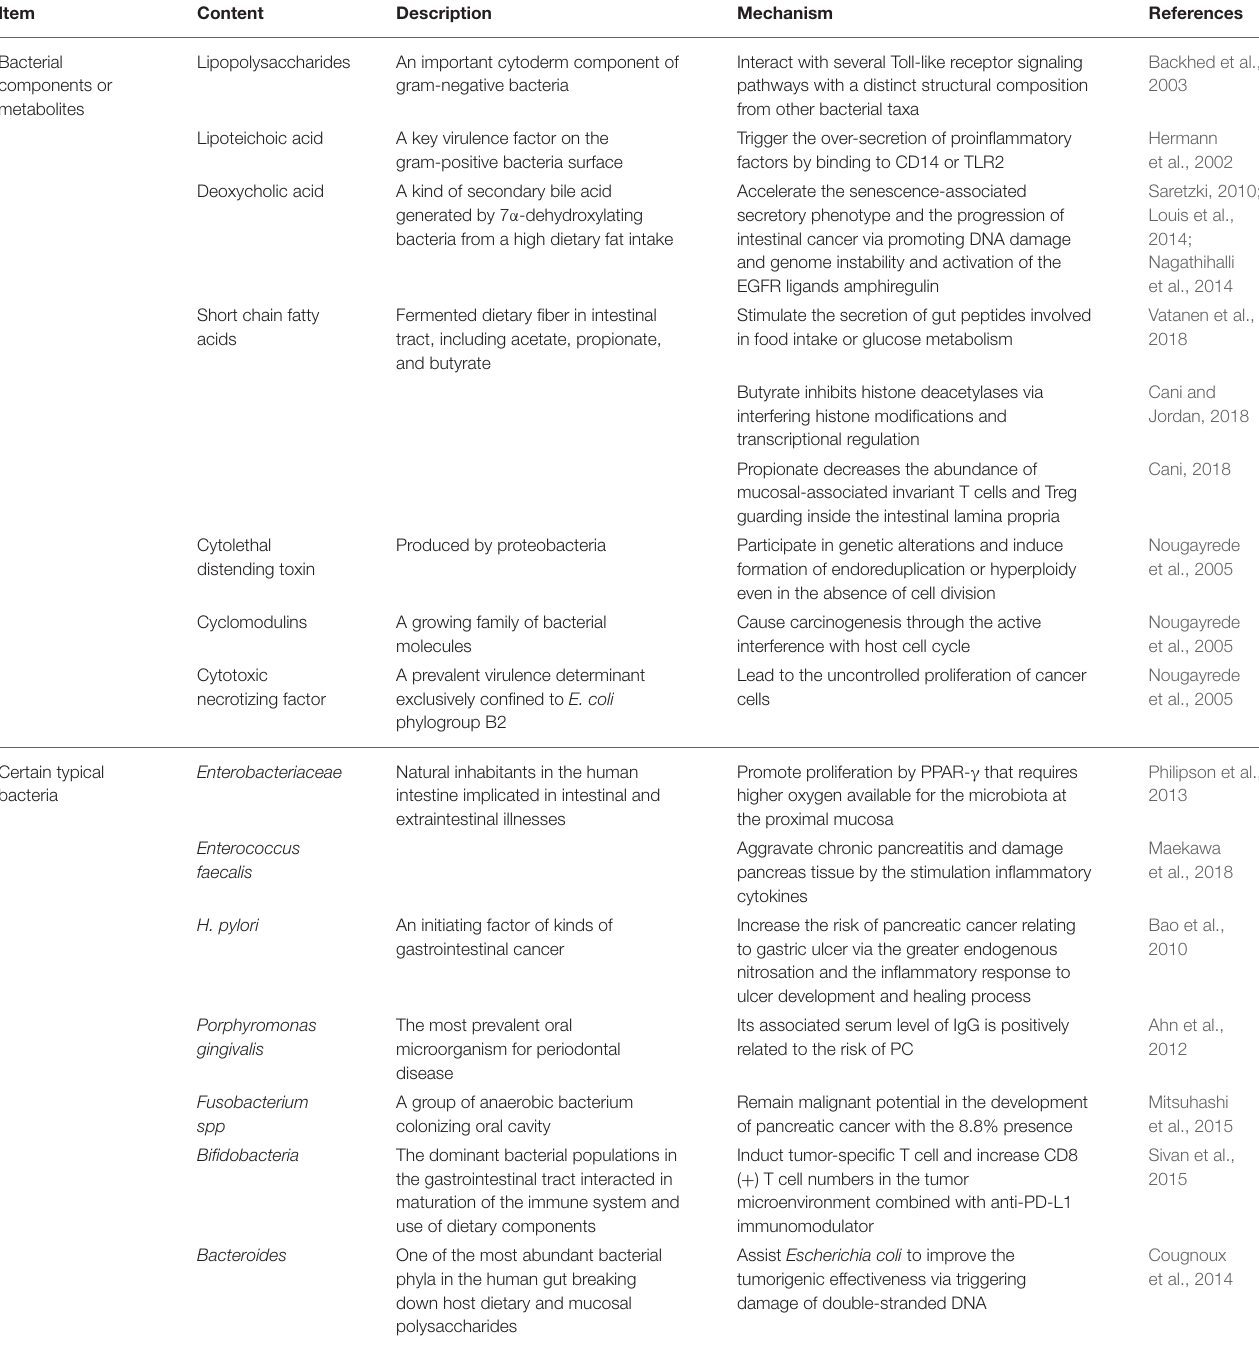
TABLE 1 | The effects of microbes, bacterial components and their metabolites in pancreatic